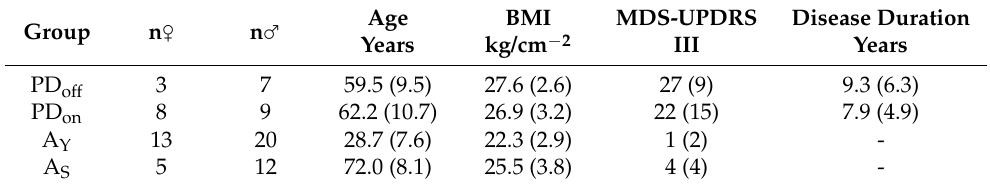
Table 1. Details of the groups involved in the study. The value between parentheses represents the standard deviation. PD off = PD patients in “OFF” medication state; PD on = PD patients in “ON”